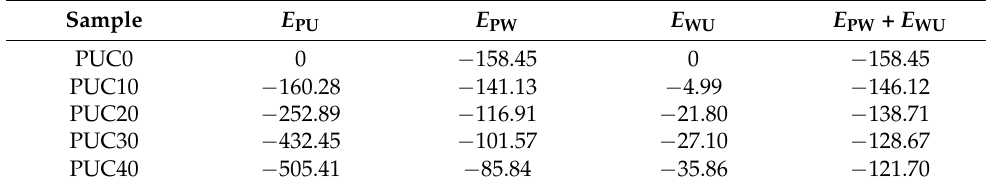
Table 3. Interaction energies (kcal/mol) between different components in the PVA composites.